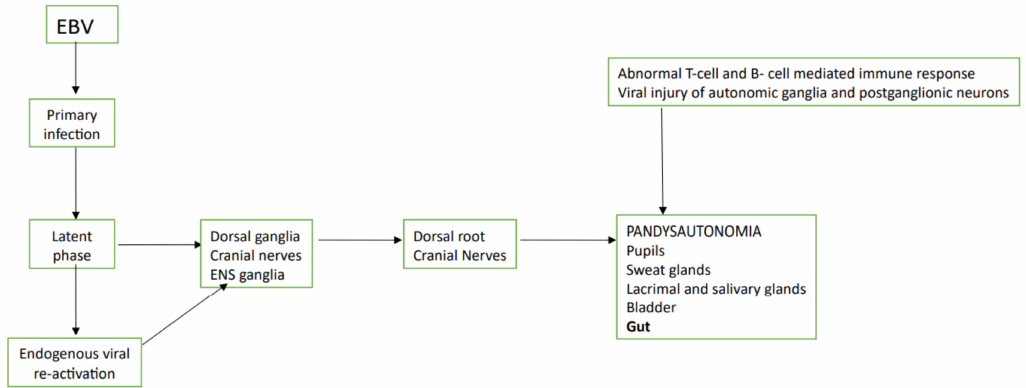
Figure 2. Pathogenesis if Epstein-Barr virus is present. ENS: enteric nervous system; EBV: Epstein-Barr